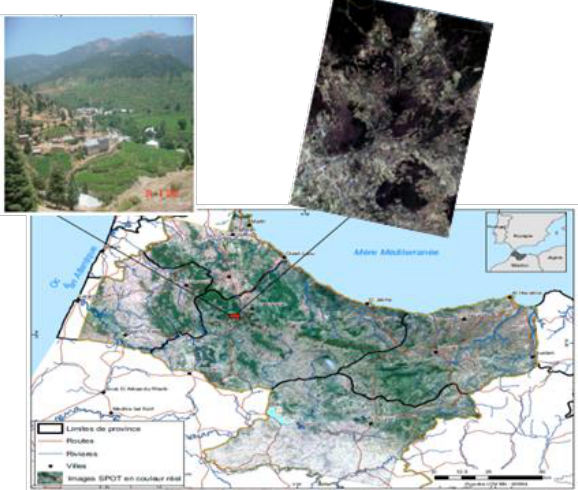
Figure 3. A tested area for Cannabis endmember selection based on ONUDC/ICMP Morocco Cannabis Survey report (UNODC, 2003)